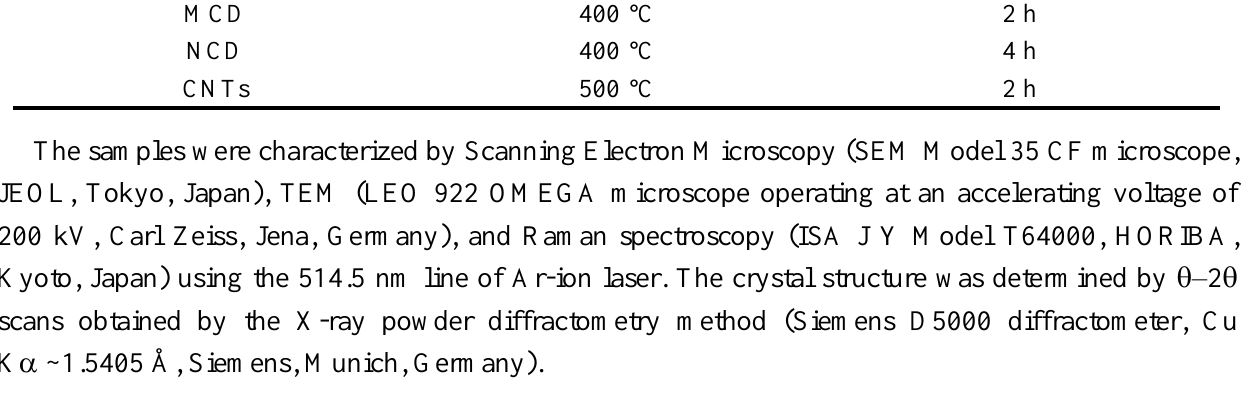
Table 2. HFCVD growth parameters employed and carbon materials grown. Material